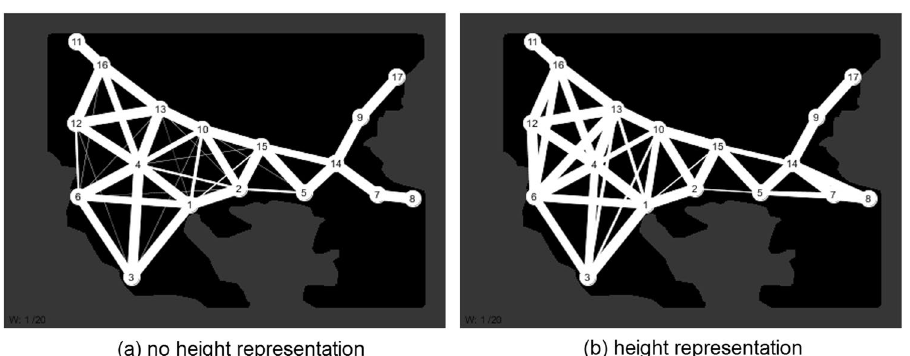
Figure 12. Proportional representation of edge weights denoting most frequently generated edges over 20 experiments, edge width is proportional to incidence. ( a ) No height representation condition, ( b ) heightfield representation condition (Connectivity analysis of simulation results from custom Processing script (https:// www.processing.org/) by author